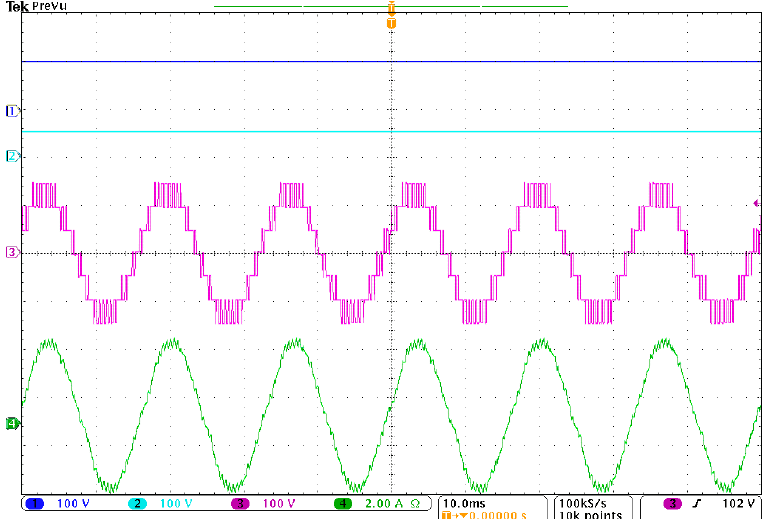
Figure 3. Seven-level MPUC inverter output voltage and current with DC source voltages. Ch 1 : V 1 , Ch 2 : V 2 , Ch 3 : V ab , Ch 4 : i l.